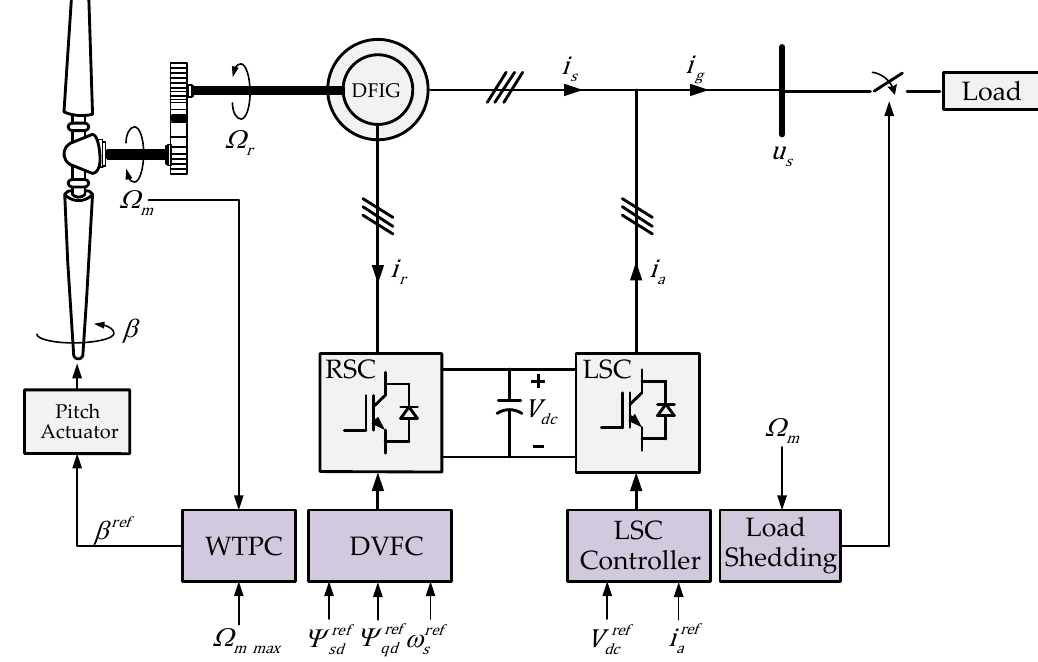
Figure 1. Schematic diagram of the Stand-Alone doubly-fed induction generator (DFIG).